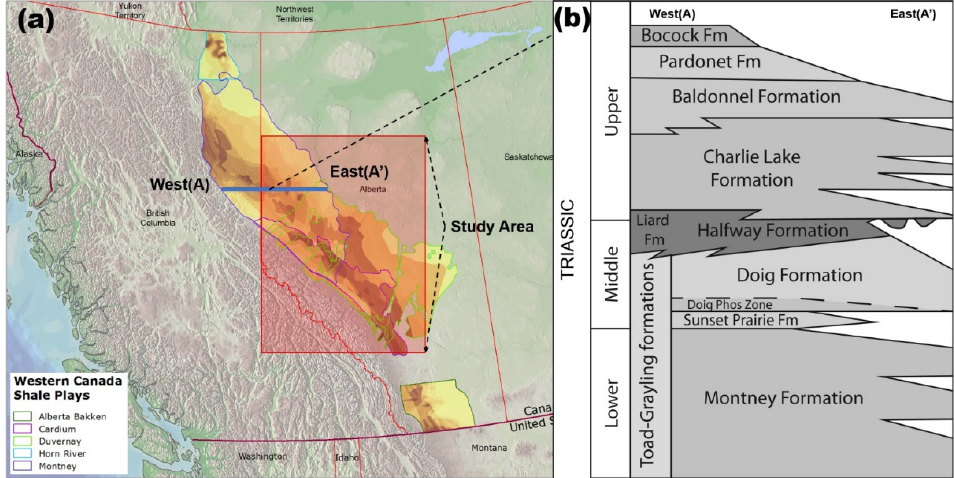
Figure 3. Location of the 1239 shale gas wells used in this study. Table 2. List of variables characteristics in the study datasets.